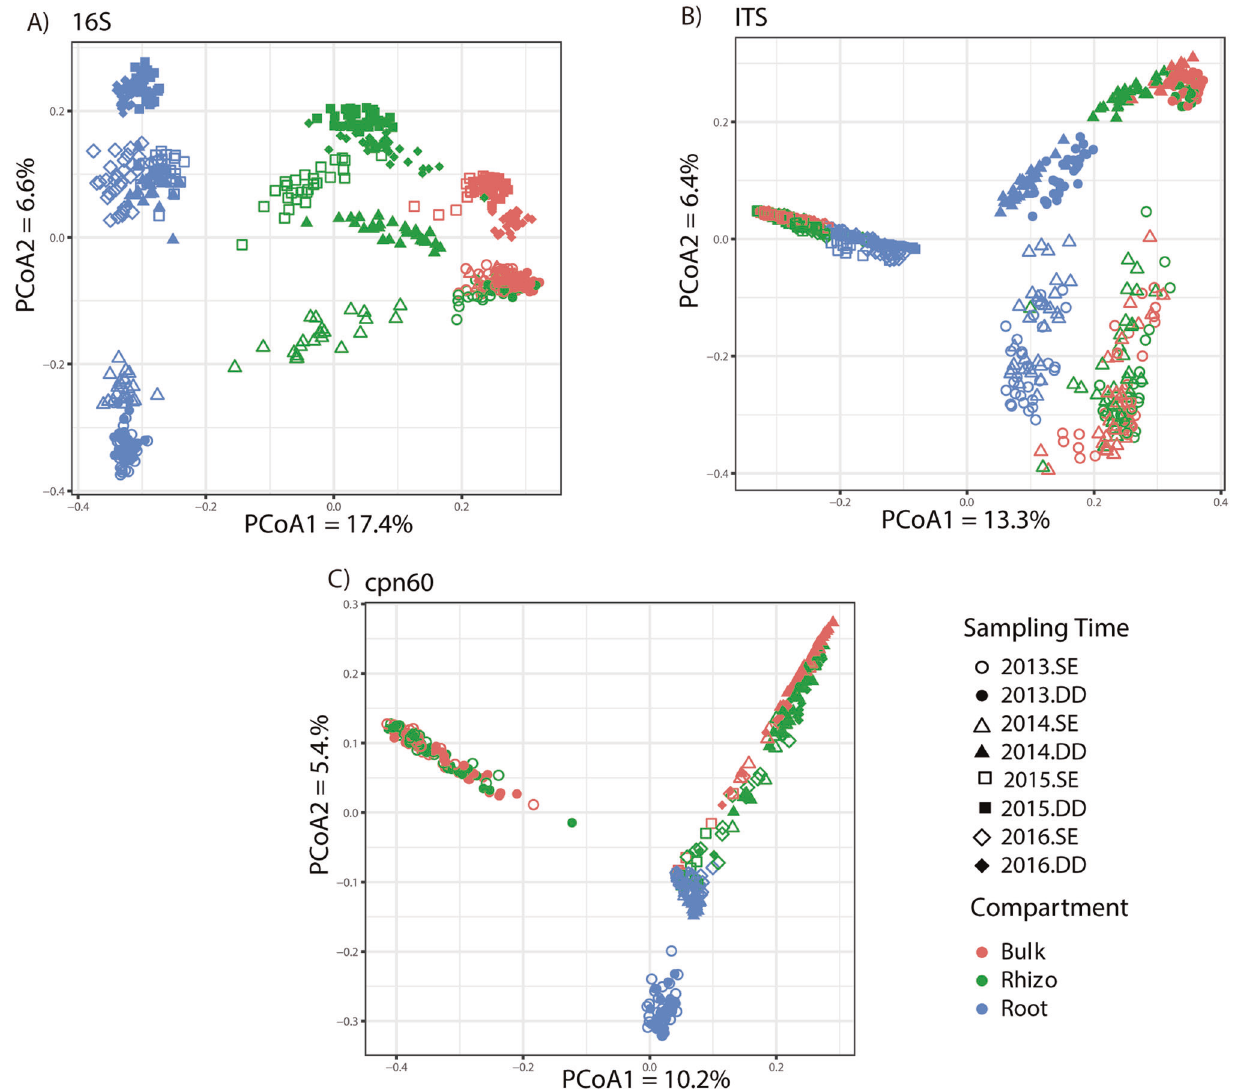
Fig. 1 Principal coordinate analysis based on Bray-Curtis dissimilarity between ASV composition. ( A ) 16 S rRNA gene amplicons, ( B ) ITS region amplicons and ( C ) cpn60 gene amplicons. SE stem elongation, DD dough